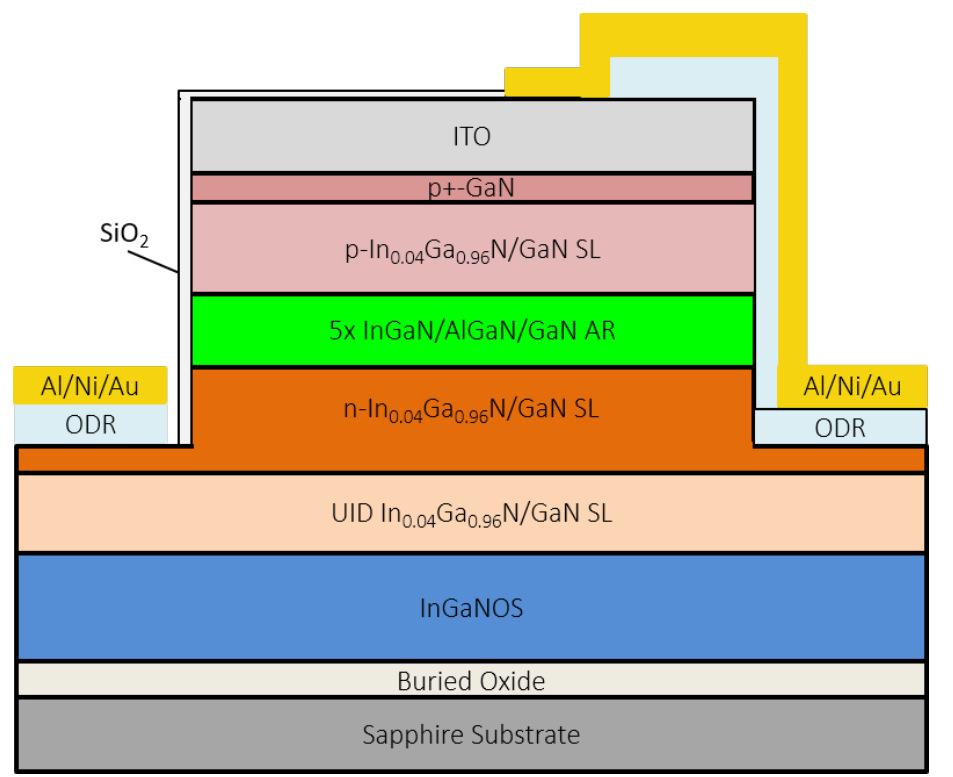
Figure 1. Cross-sectional schematic of finished fabricated device with epilayer sections